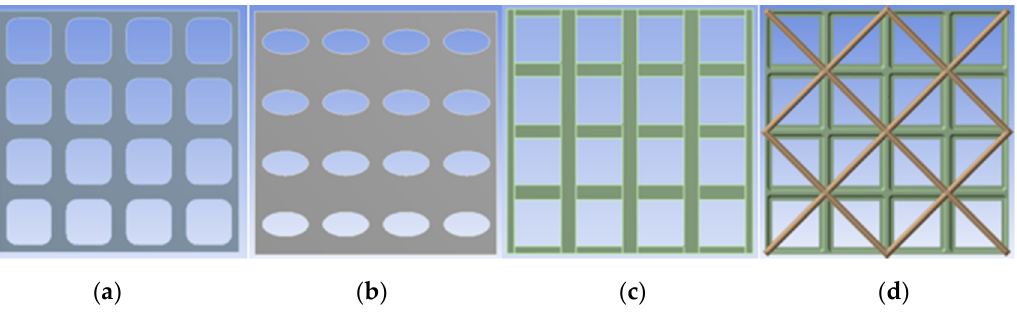
Figure 2. Shape definition: four geometries were considered: ( a ) rounded rectangles and ( b ) ellipses holes, or ( c ) rectangular and ( d ) triangles in quadridirectional grids. Table 4. Geometrical parameters for optimization.